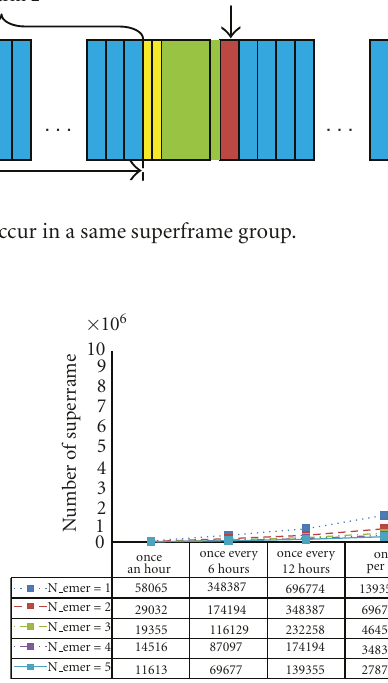
Figure 9: Required EGTS rate factor by emergency tra ffi c condition with BI =